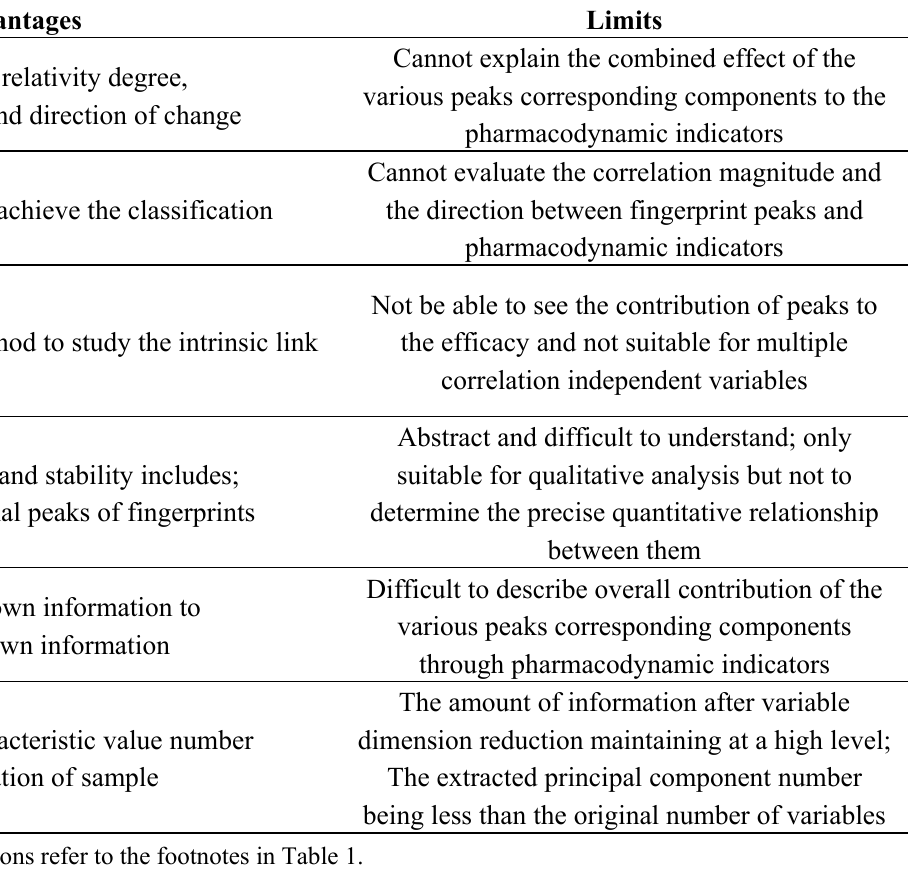
Table 4. Common analytical methods applied in spectrum-effect